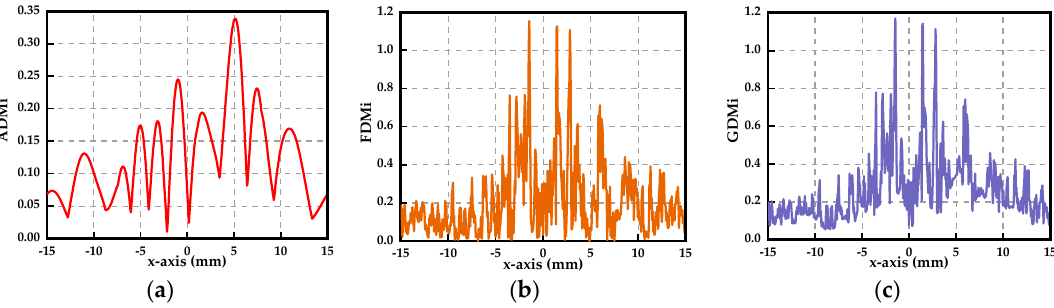
Figure 18. Calculated ( a ) ADM, ( b ) FDM and ( c ) GDM point-by-point comparisons of the data of Figure 17.